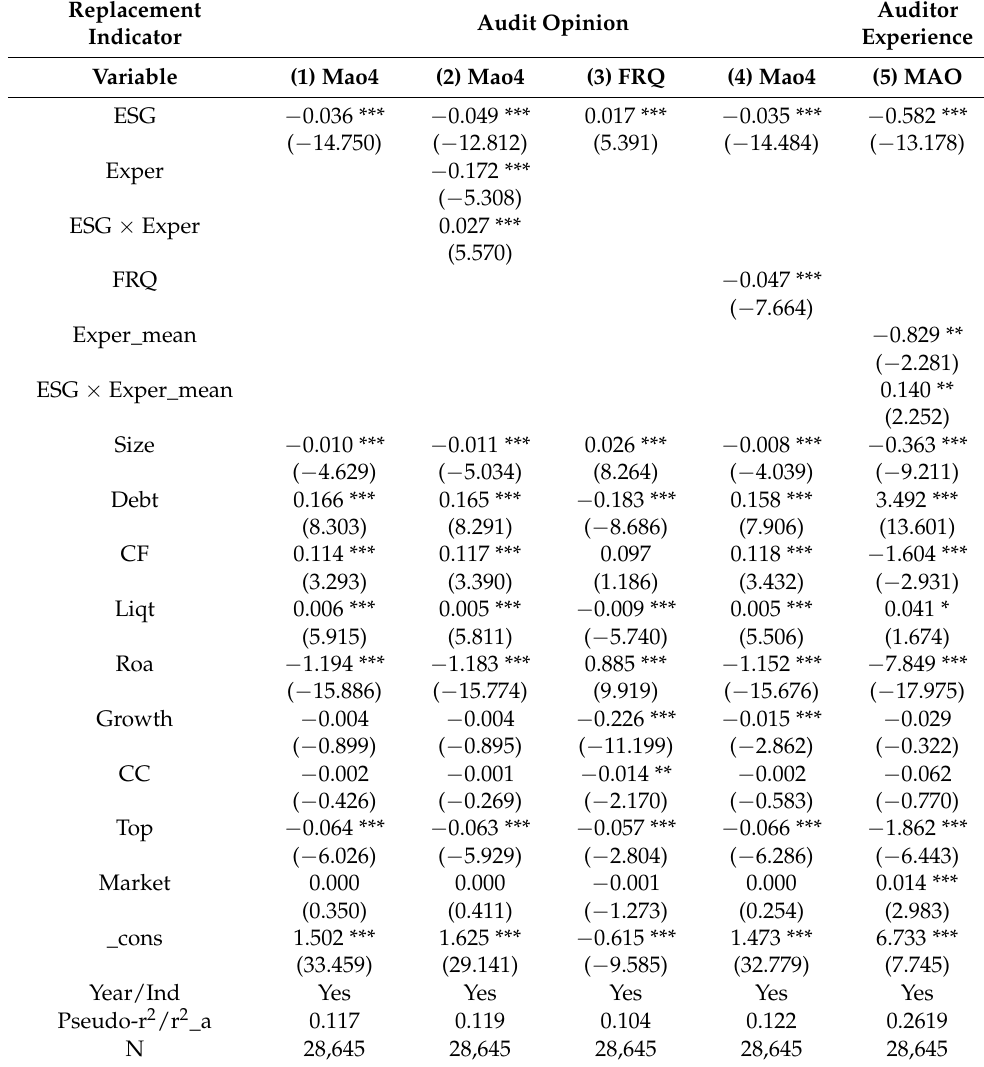
Table 6. Changing the measurement of audit opinion and auditor